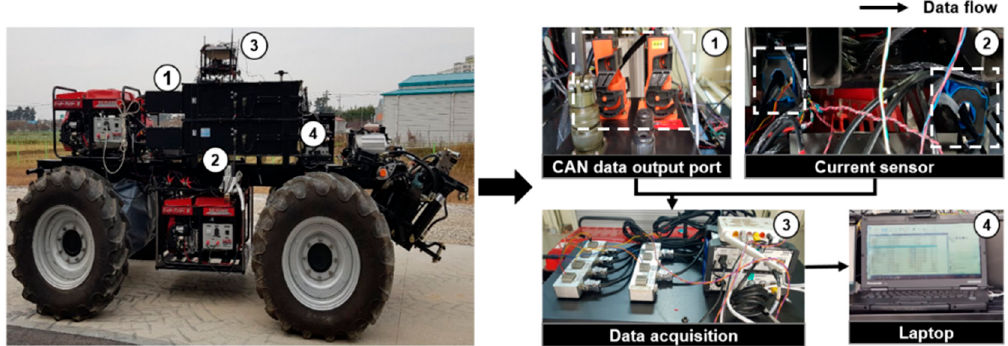
Figure 4. Load measurement system and data flow of electric AWD tractor.